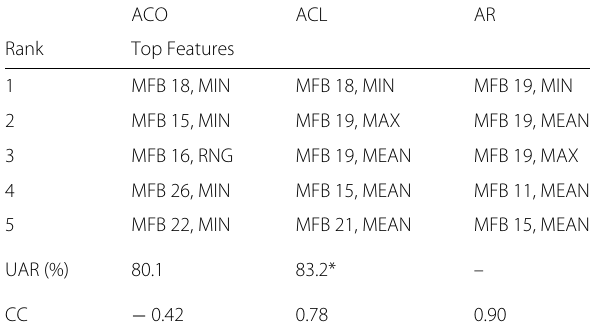
Table 2 Example comparison of top-ranked features for different training objective